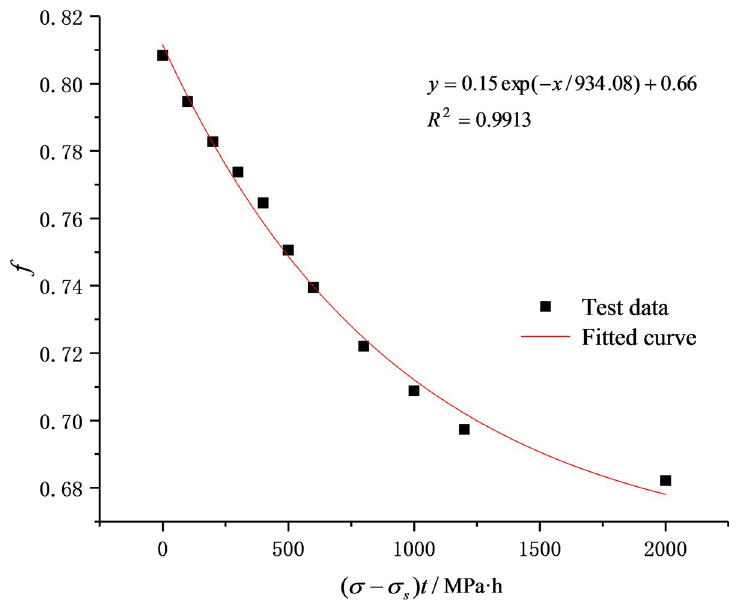
Fig 3. Relationship between internal friction coefficient and ( σ - σ s ) t .